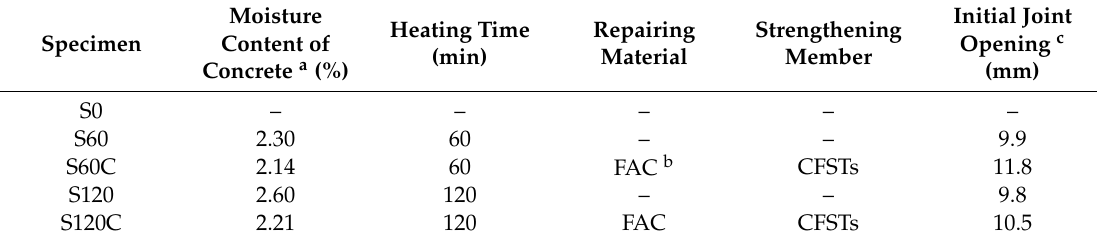
Table 1. Details of the test arrangement.